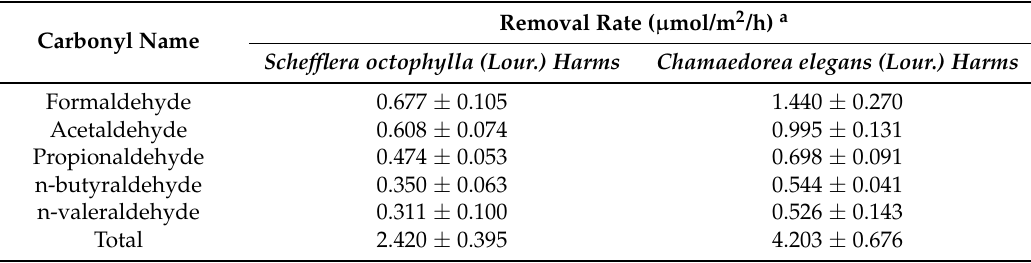
Table 1. Removal rates for C 1 to C 5 aldehydes by two houseplant